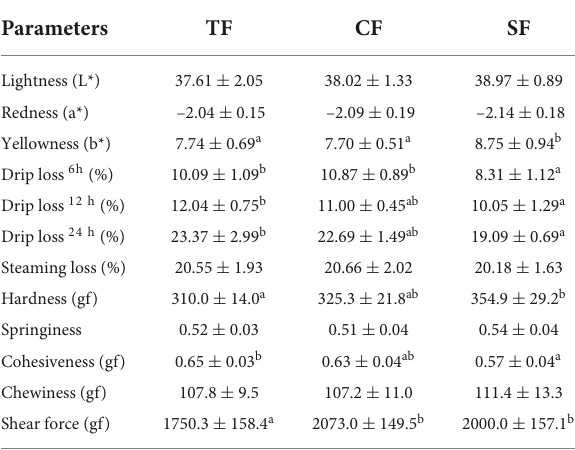
TABLE 5 Flesh color, water-holding capacity and texture characteristics of largemouth bass fed trash fish and formula feeds. 1